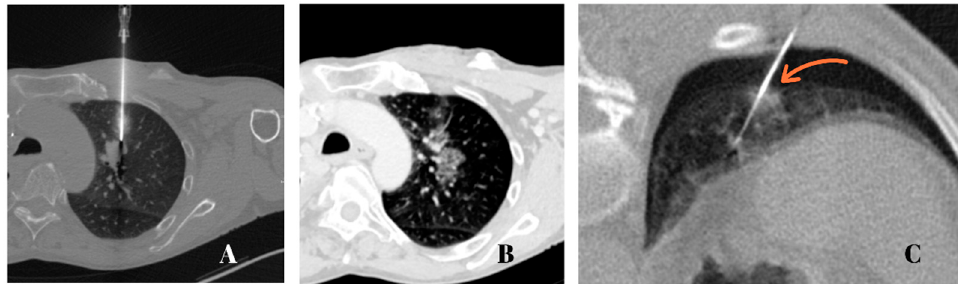
Figure 2. Axial CT images of the lungs at 75 mA, 120 kV, and a 2 mm slice thickness with a 1 mm increment: ( A ) A pulmonary mass is seen in the left upper lobe as the needle is entering the pleura at a 90° angle; ( B ) Post-intervention control scan showing a slight needle tract hemorrhage with no evidence of pneumothorax; ( C ) An intraprocedural pneumothorax as the needle enters the pleura at a very steep angle to target a pulmonary nodule (orange arrow) in the right lower lobe.